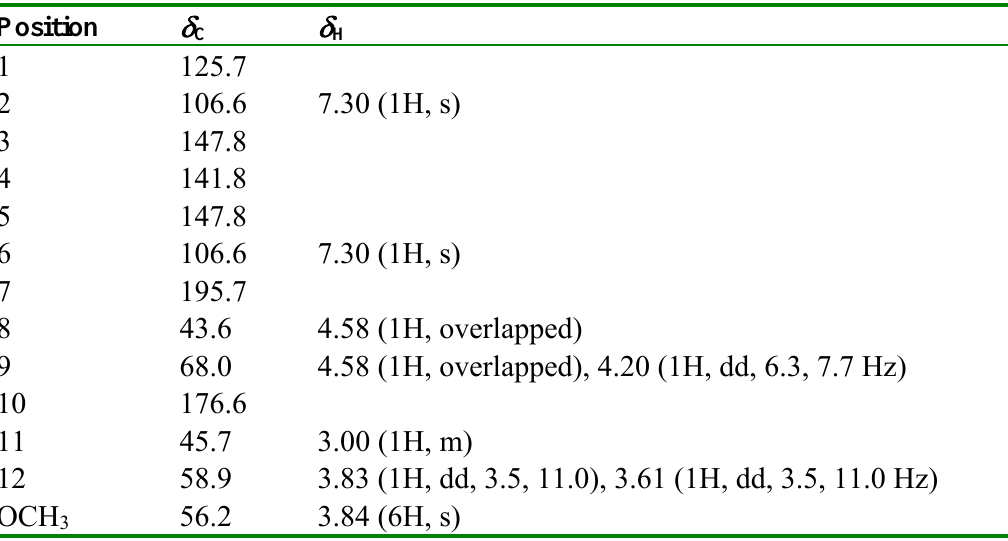
Figure 2. Key HMBC and ROESY correlations of compound 1 .